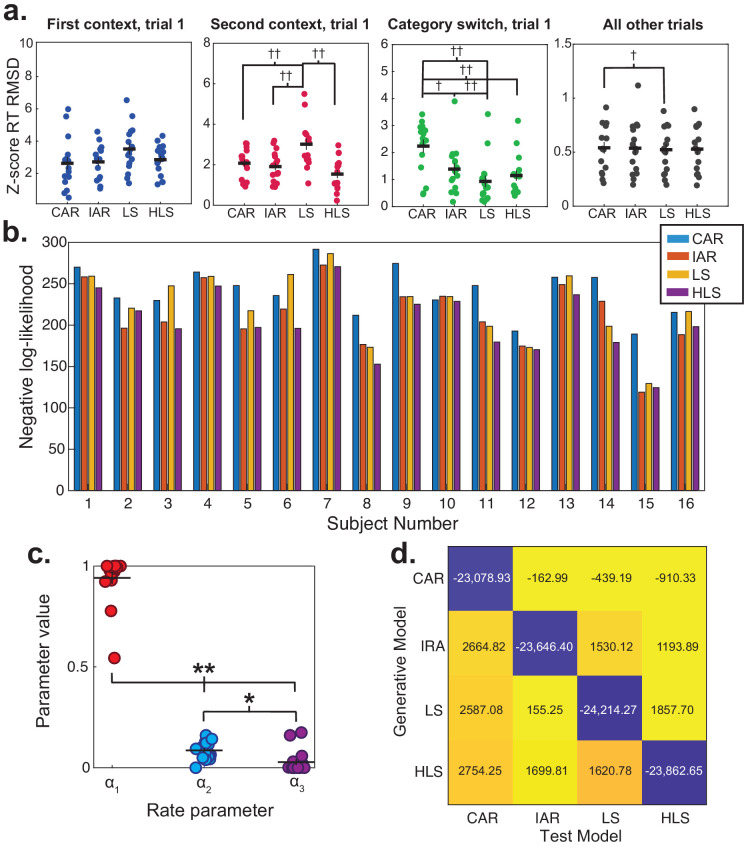
Supplementary analyses for computational modeling of reaction times (RTs).Data are from session 2 of the mini-blocked generalization phase for participants in the fMRI group. (a) Root-mean squared deviation between data simulated from each model and participants’ z-scored reaction times for different trial-types. †p<0.05, ††p<0.01, repeated-measures t-tests, Bonferroni corrected for multiple comparisons. (b) Negative log-likelihoods for each participant in the fMRI group for conjunctive associative retrieval (CAR), independent associative retrieval (IAR), latent state (LS), and hierarchical latent state (HLS) models. Lower values indicate a better fit. (c) Values for three rate parameters governing rate of activation change in nodes due to direct (α1), mediated (α2), and incidental retrieval (α3). (d) Cross model comparison using best fitting parameters from 16 participants to generate simulated data, tested with alternative. Values indicate negative log-likelihood of model fits. **p=0.001, *p<0.05, Wilcoxon signed rank test, Bonferroni corrected for multiple comparisons.